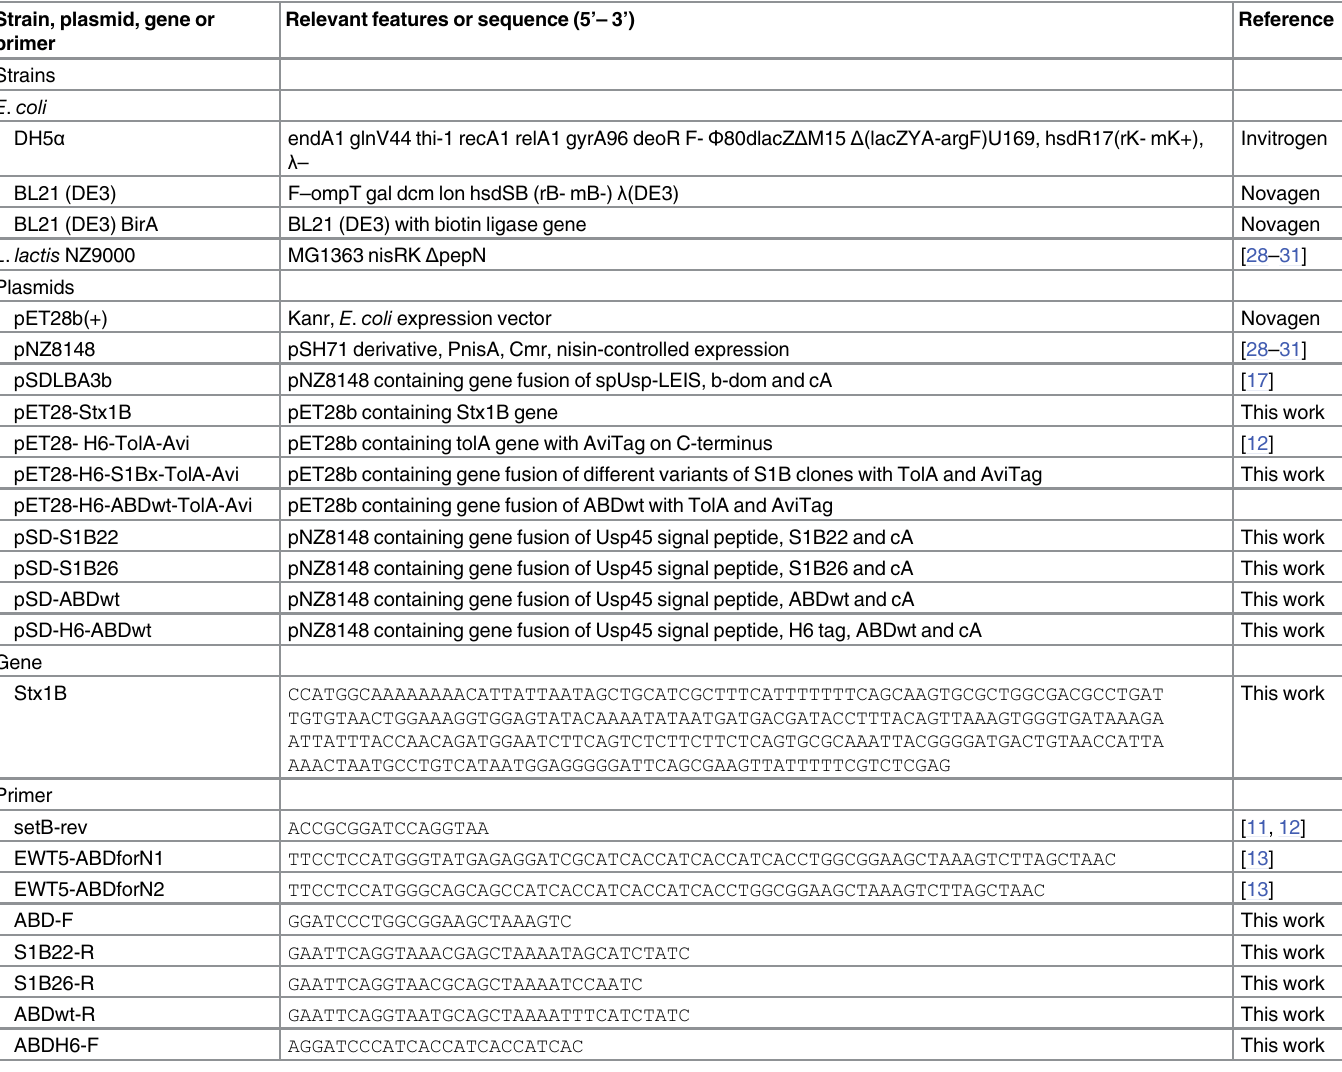
Table 1. Strains, plasmids, gene and primers used in this study. Strain, plasmid, gene or Relevant features or sequence (5 ’– 3 ’ primer